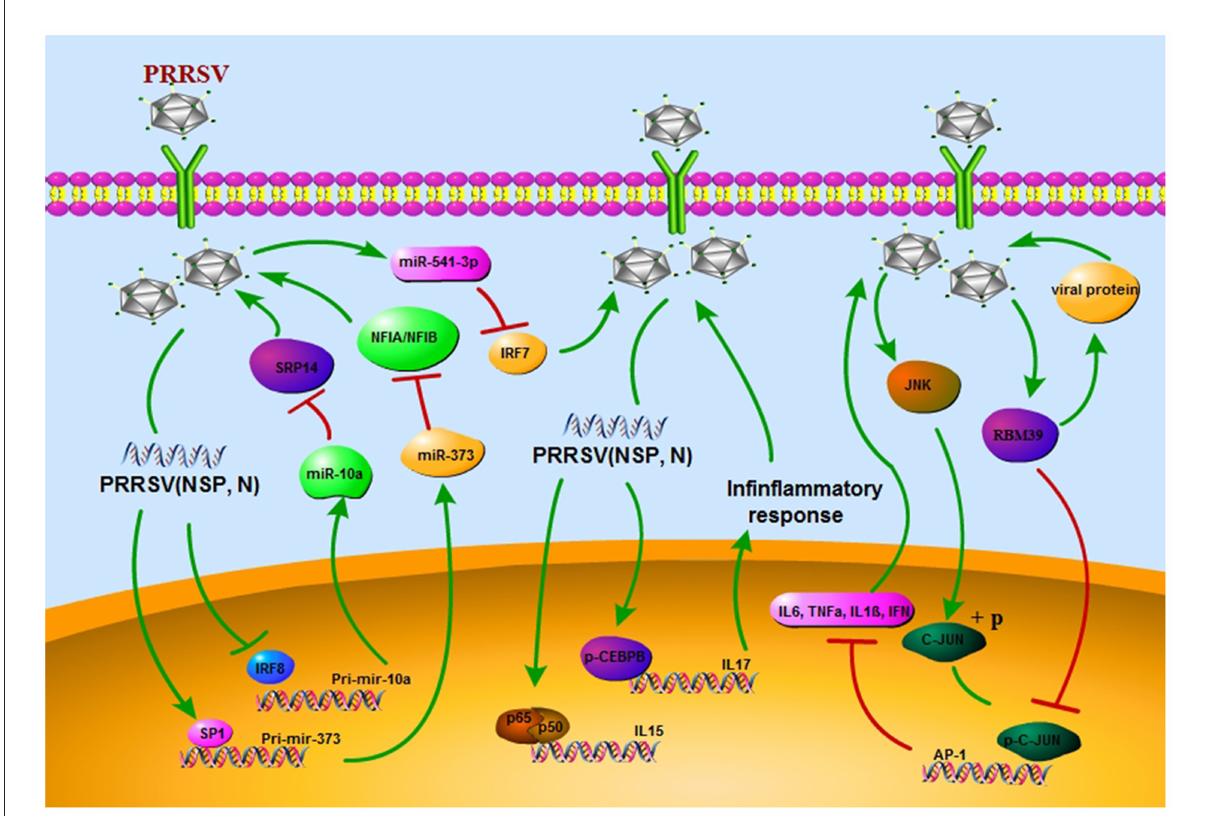
FIGURE2 PRRSV escapes the host immune response through different strategies. First, the regulatory network of transcription factors/miRNAs promotes viral replication in vivo . Secondly, it acts on inflammatory factors, exacerbates inflammatory response. In addition, viral replication is promoted by nuclear localization and phosphorylation of transcription